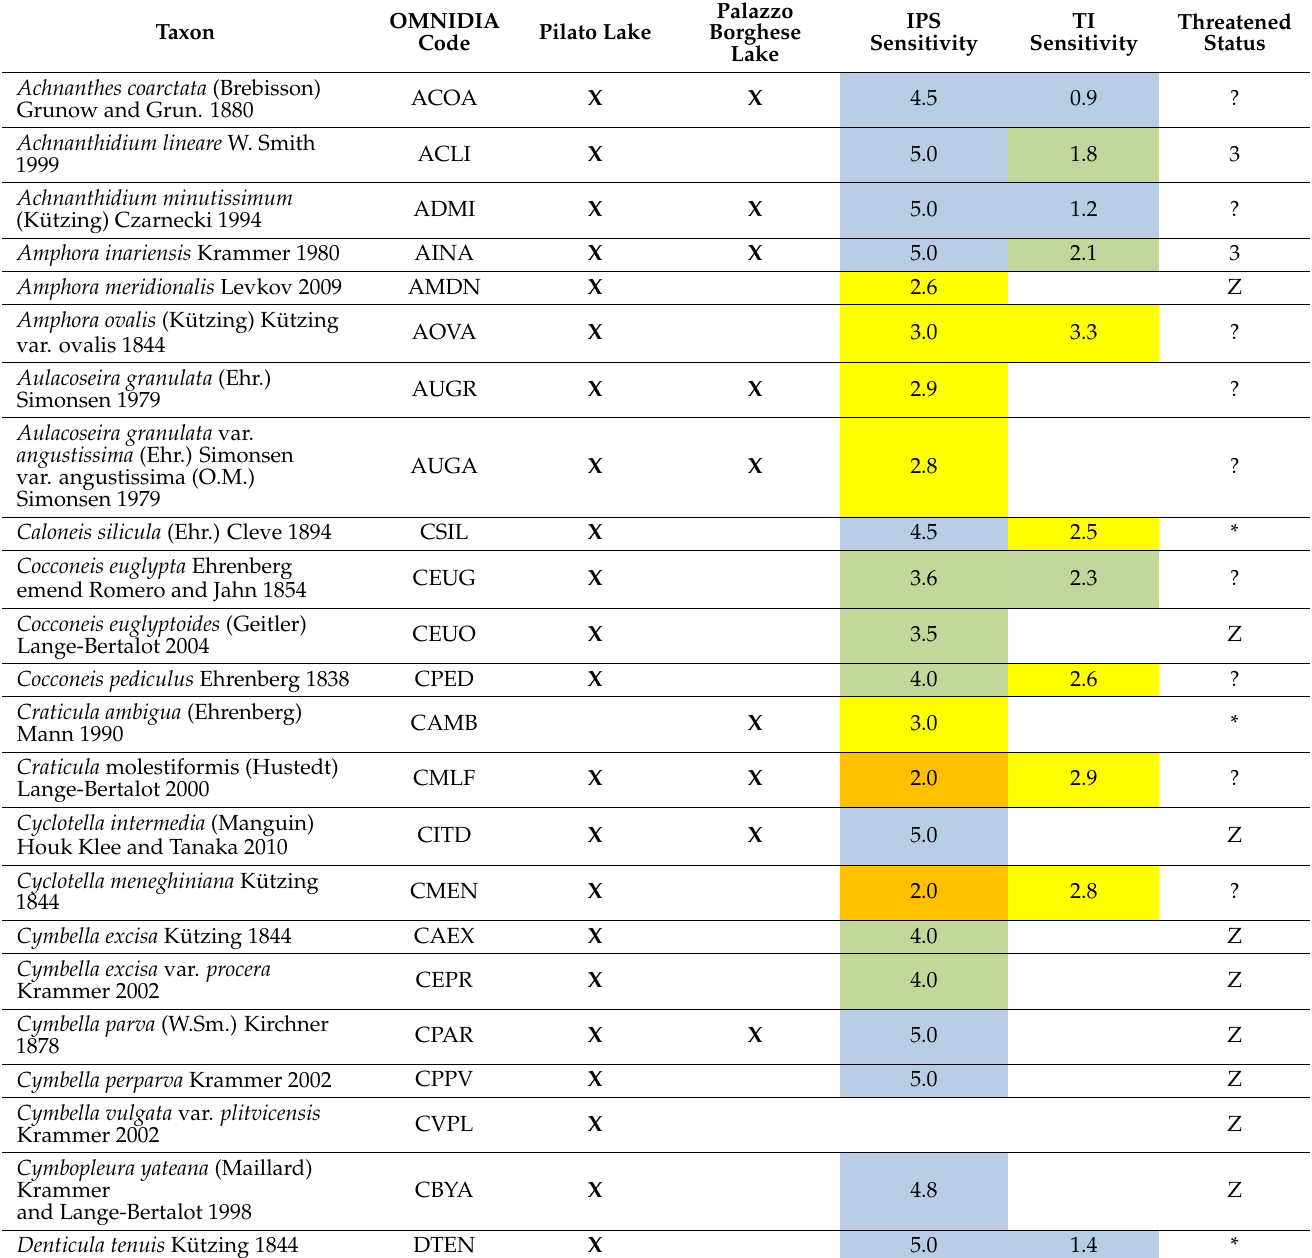
Table 2. List of the 111 species of diatoms recognized in the Pilato and Palazzo Borghese lakes in 2019. For the species for which they are available, the values of diatomic indices IPS [27] and TI [28], and the threatened status according to Lange-Bertalot Red List criteria [40] were reported. The different quality classes are indicated with the following colours: light blue = Class I (High); green = Class II (Good); yellow = Class III (Moderate); orange = Class IV (Poor); red = Class V (Bad). 2 = severely endangered (species showing significant population decline or subject to substantial threat caused by human impact); 3 = endangered (species showing a significant population decline or one that is probably threatened by human impact); G = at risk (threatened species, but available information is not sufficient to allow an assignment to categories 1 to 3); Z = not classified; ? = not threatened (species populations have increased, are stable or have decreased slightly); * = currently not considered threatened V = decreasing (species displaying a substantial population decline but not yet considered as threatened); R = extremely rare (extremely rare species for which there are only one to six records); D = data deficient (information on the distribution, biology or level of threat is